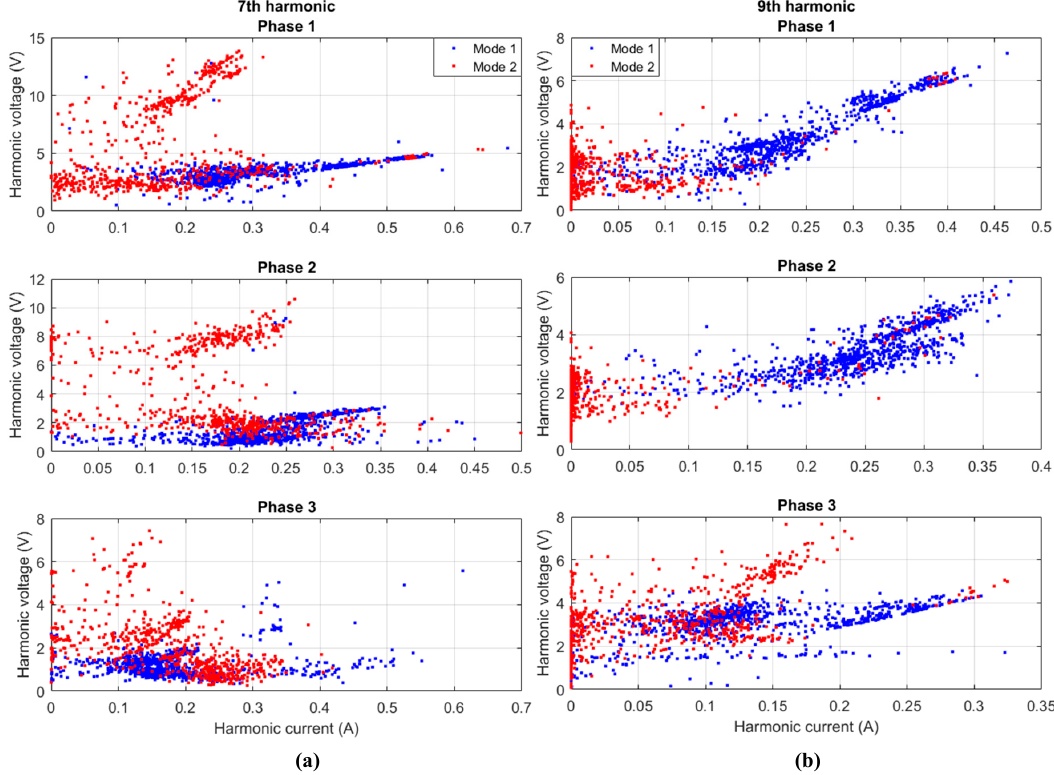
Figure 21. ( a ) The 1 h 7th harmonic voltage and current values plotted against each other for mode 1 and 2 seen in Figures 14–16. ( b ) The 1 h 9th harmonic voltage and current values plotted against each other for mode 1 and 2 seen in Figures 14–16.